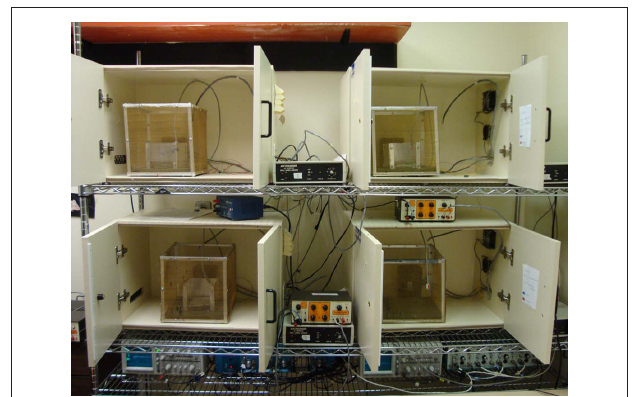
Figure 4 | eyeblink classical conditioning is a form of associative learning in which a previously neutral stimulus such as a tone or light (CS) is presented briefly before a blink-inducing unconditioned stimulus (uS), such as a puff of air to the eye or a shock to the muscles around the eye. In the standard delay paradigm, the CS and US overlap, and coterminate. After repeated pairings, the animal learns to associate the stimuli and begins to blink to the CS before the onset of the US – a behavior termed conditioned